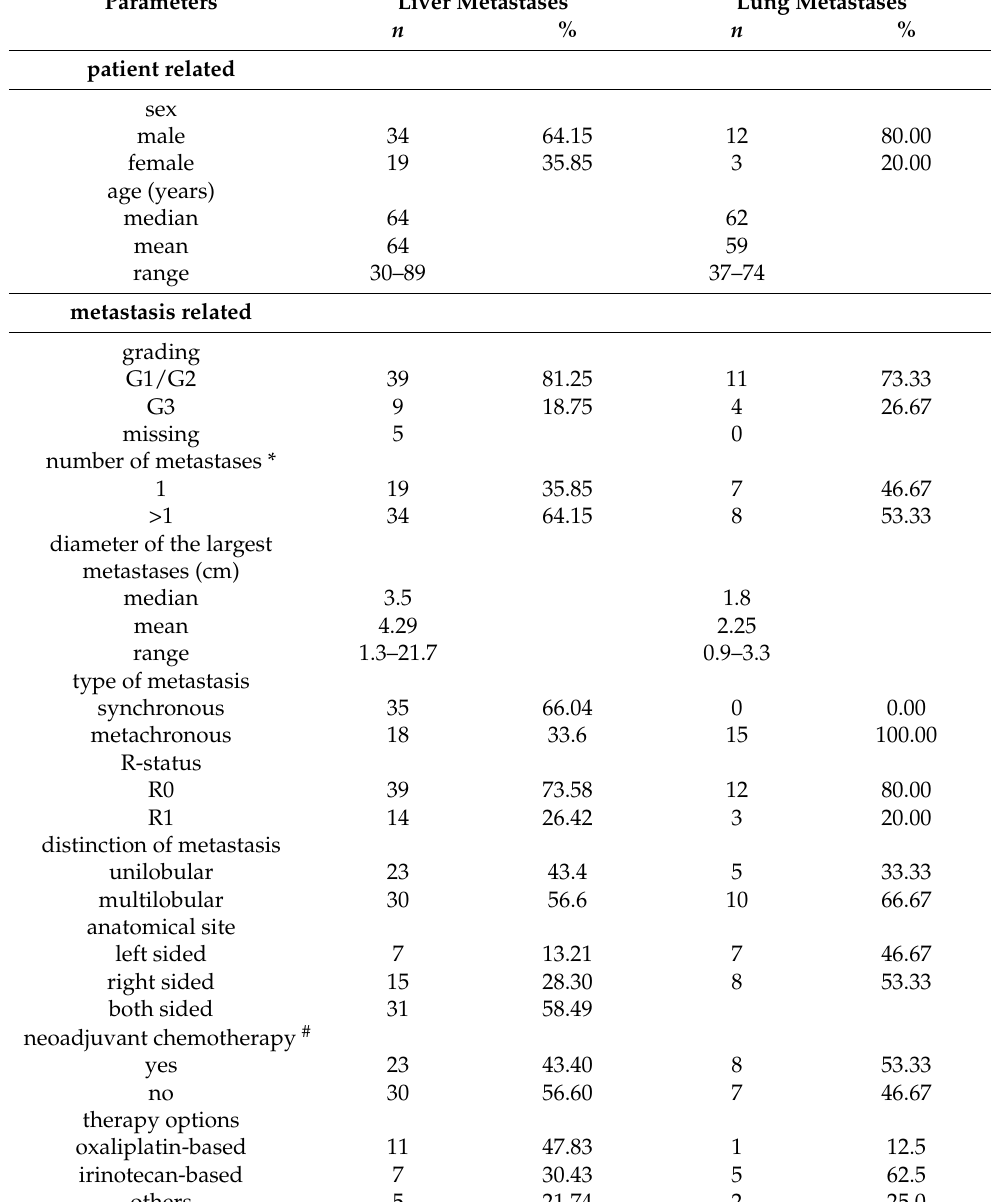
Table 2. Patient